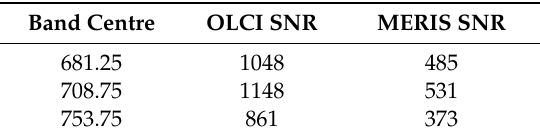
Table 1. Sentinel-3 OLCI and Envisat MERIS spectral band signal-to-noise ratio (SNR) Band